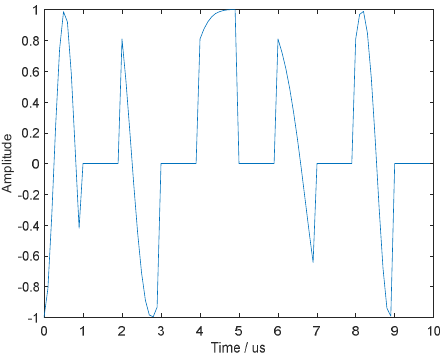
Figure 2. The time-domain waveform of ISRJ.